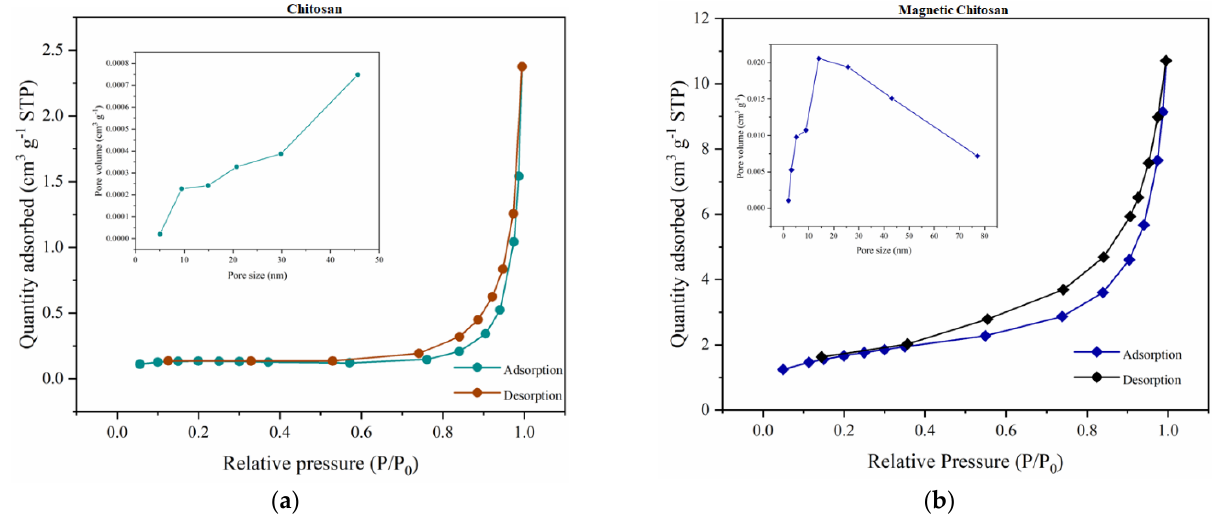
Figure 6. Textural properties of ( a ) CS and ( b ) CS·Fe 3 O 4 .